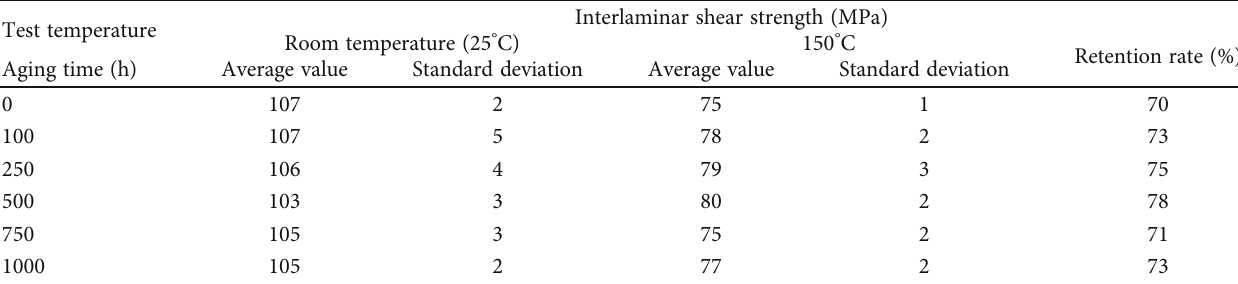
Table 7: The thermal aging properties of CCF800/5228 composites — interlaminar shear